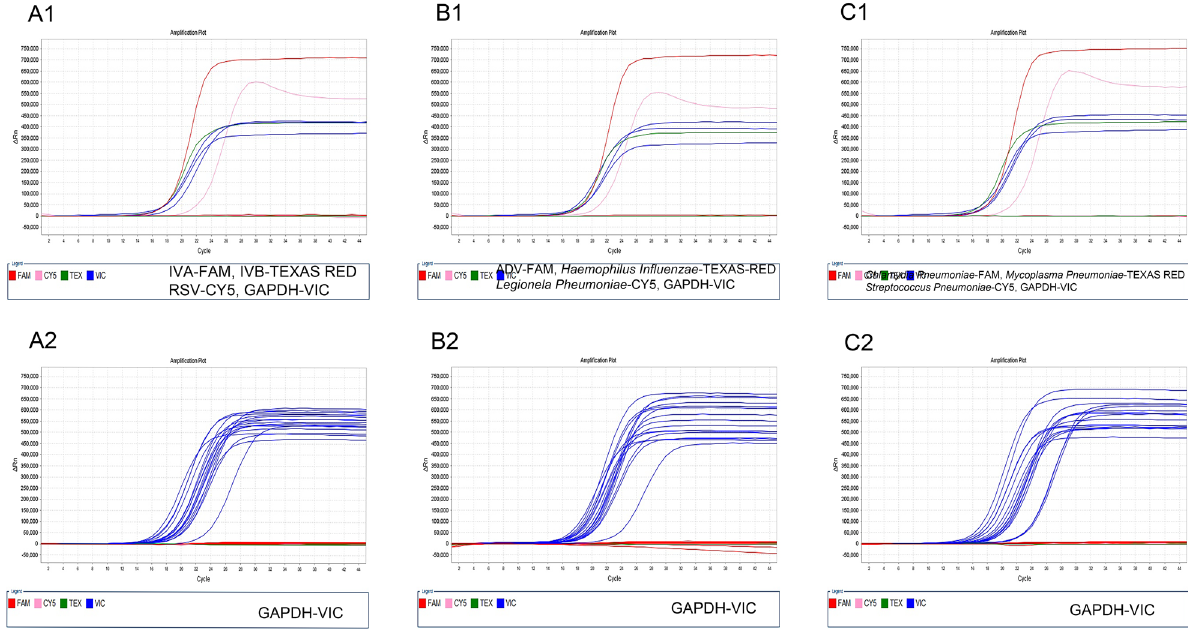
Figure 2. Specificity of multiplex real-time PCR. A1, B1 and C1 show that FAM, TEXAS RED and Cy5 fluorescent signals were generated only by the target pathogens and non-target pathogens were not amplified by the assay, and VIC fluorescent signals were selectively displayed to indicate the internal reference gene GAPDH amplified from the corresponding target pathogens. A2, B2 and C2 show that the VIC fluorescent signals from the DNA of the GAPDH gene for all other existing pathogens were generated by the three-tube real-time PCR system to exclude false negative